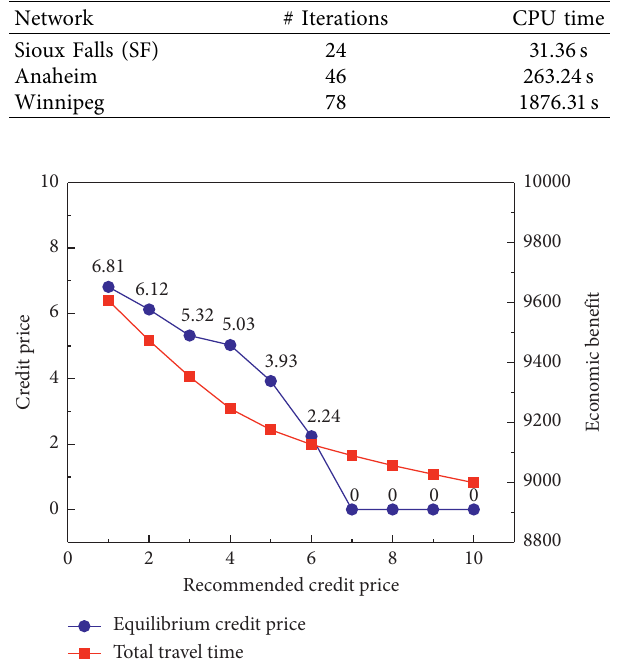
Figure 2: Convergence plots for equilibrium credit price with different recommended credit prices. Table 2: Iterations and CPU times needed for convergence of the proposed algorithm.